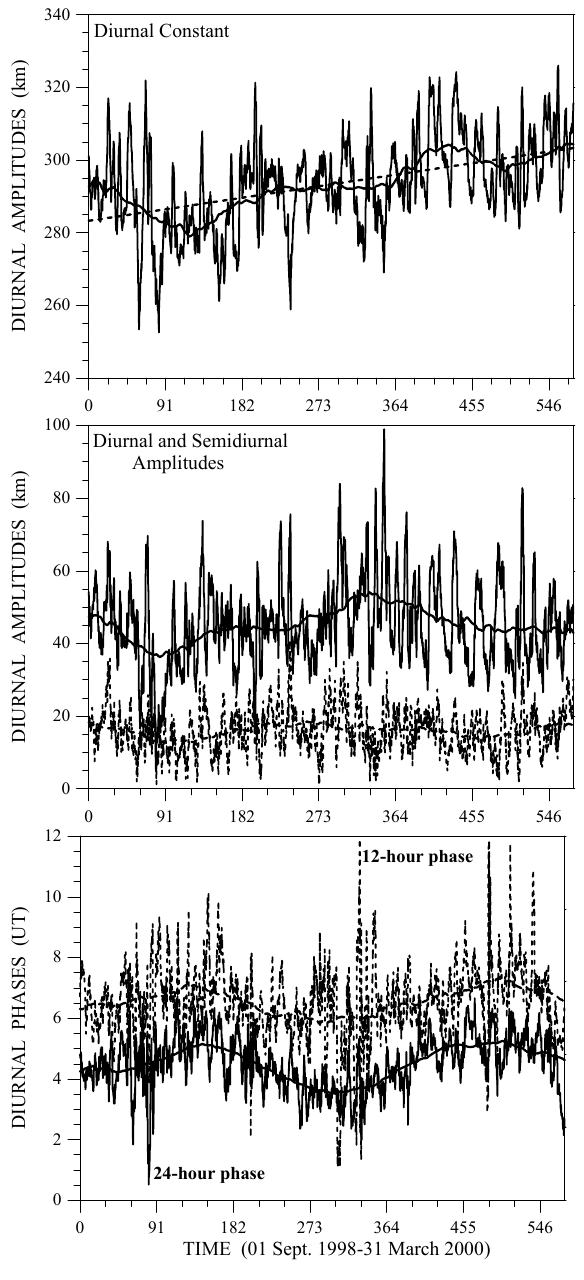
Fig. 8. Variability of the diurnal components of hm F2: the upper plot describes the diurnal mean, the middle plot shows the ampli- tudes of 24-h (solid line) and 12-h (dashed line) harmonics and the bottom plot shows their phases. The thick solid or dashed lines in these plots describe the seasonal courses of these diurnal compo- nents obtained as the 3-month running